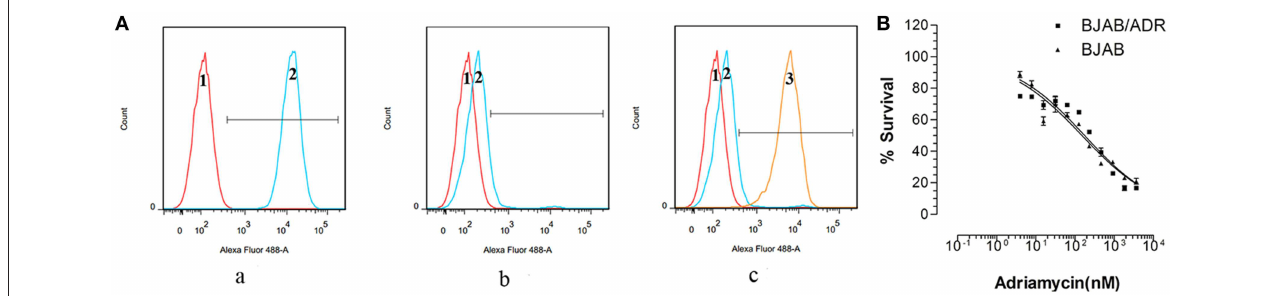
FIGURE 4 | Intercellular accumulation and efflux of Rho 123. (A) Flow cytometry measured intracellular accumulation and efflux of Rho 123. (a) Treatment of BJAB cells with Rho 123 resulted in Rho 123 accumulation in parental cells. (b) Decreased fluorescence intensity of Rho 123 in BJAB/ADR cells compared with that in the BJAB cells. (c) The chemo-drug accumulation significantly increased after BJAB/ADR cells treated with verapamil, an inhibitor of ABCB1 transporter, for 1h (1 represents negative cells, 2 represents positive cells and 3 represents BJAB/ADR positive cells treated with verapamil). (B) Verapamil reversed the chemoresistance of BJAB/ADR cells to adriamycin, thus increasing the sensitivity of the drug-resistant cells to adriamycin.